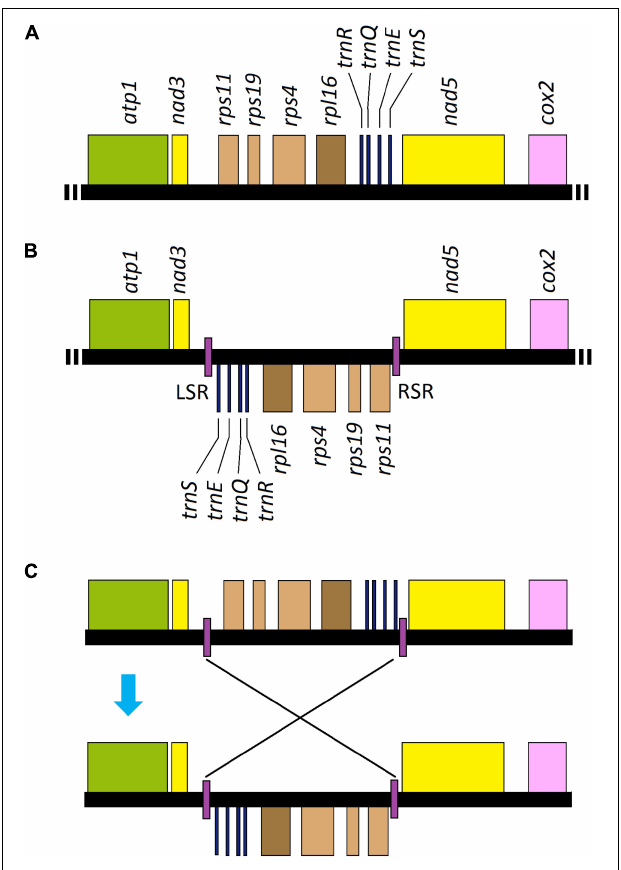
FIGURE 6 | Intraspecific genome rearrangement of U. compressa mitogenome: (A) gene order from nad3 to nad5 in mitogenomes of Uco2-5 as well as the other Ulva species; (B) gene order from nad3 to nad5 in mitogenome of Uco1 with the specific inverted repeat (IR), and its left stem region (LSR) and right stem region (RSR) were located in two boundaries of the inverted eight gene block, respectively, and (C) hypothesis of the rearrangement event related to the specific IR element in Uco1